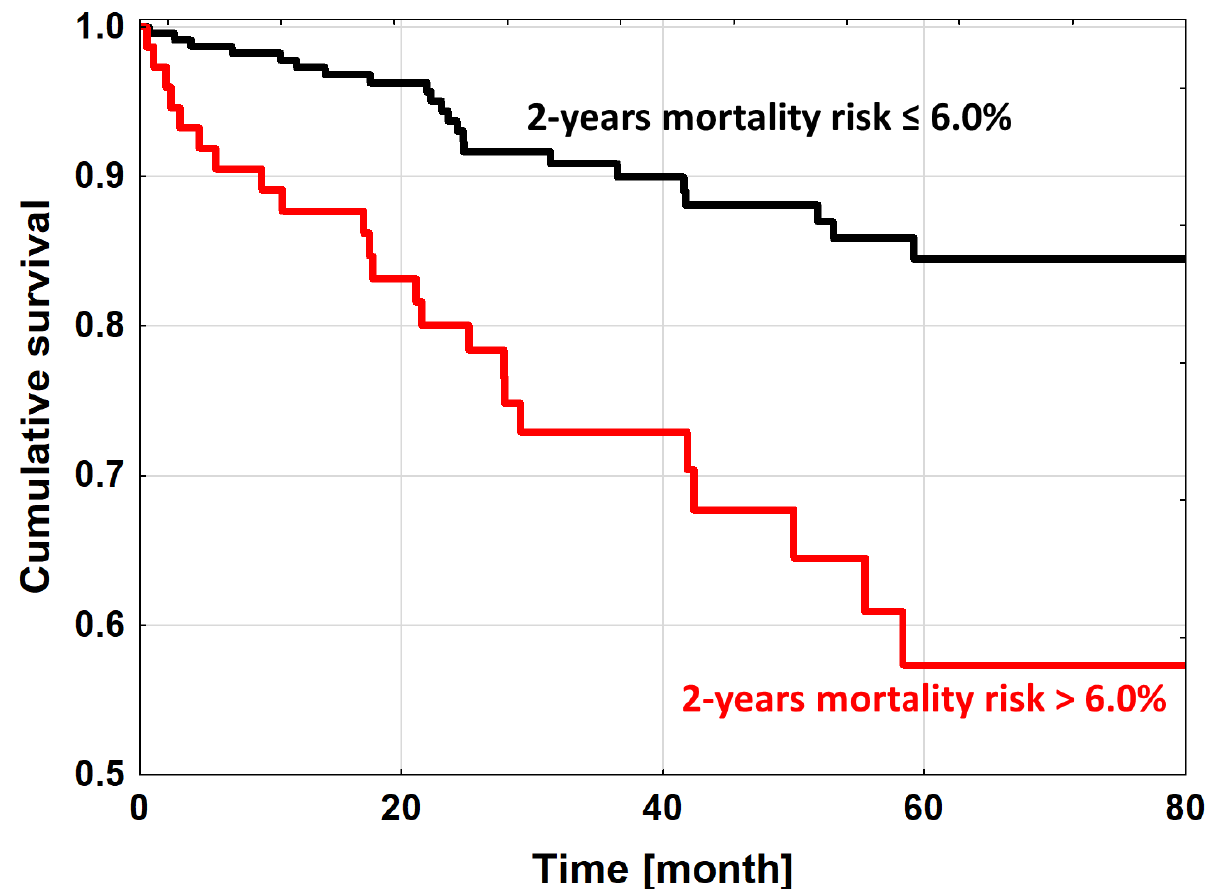
Figure 2. The Kaplan–Meier survival for high (4th quartile) and non-high (from 1st to 3rd quartiles) mortality risk groups divided according to calculations based on the Krakow DCM Risk Score.